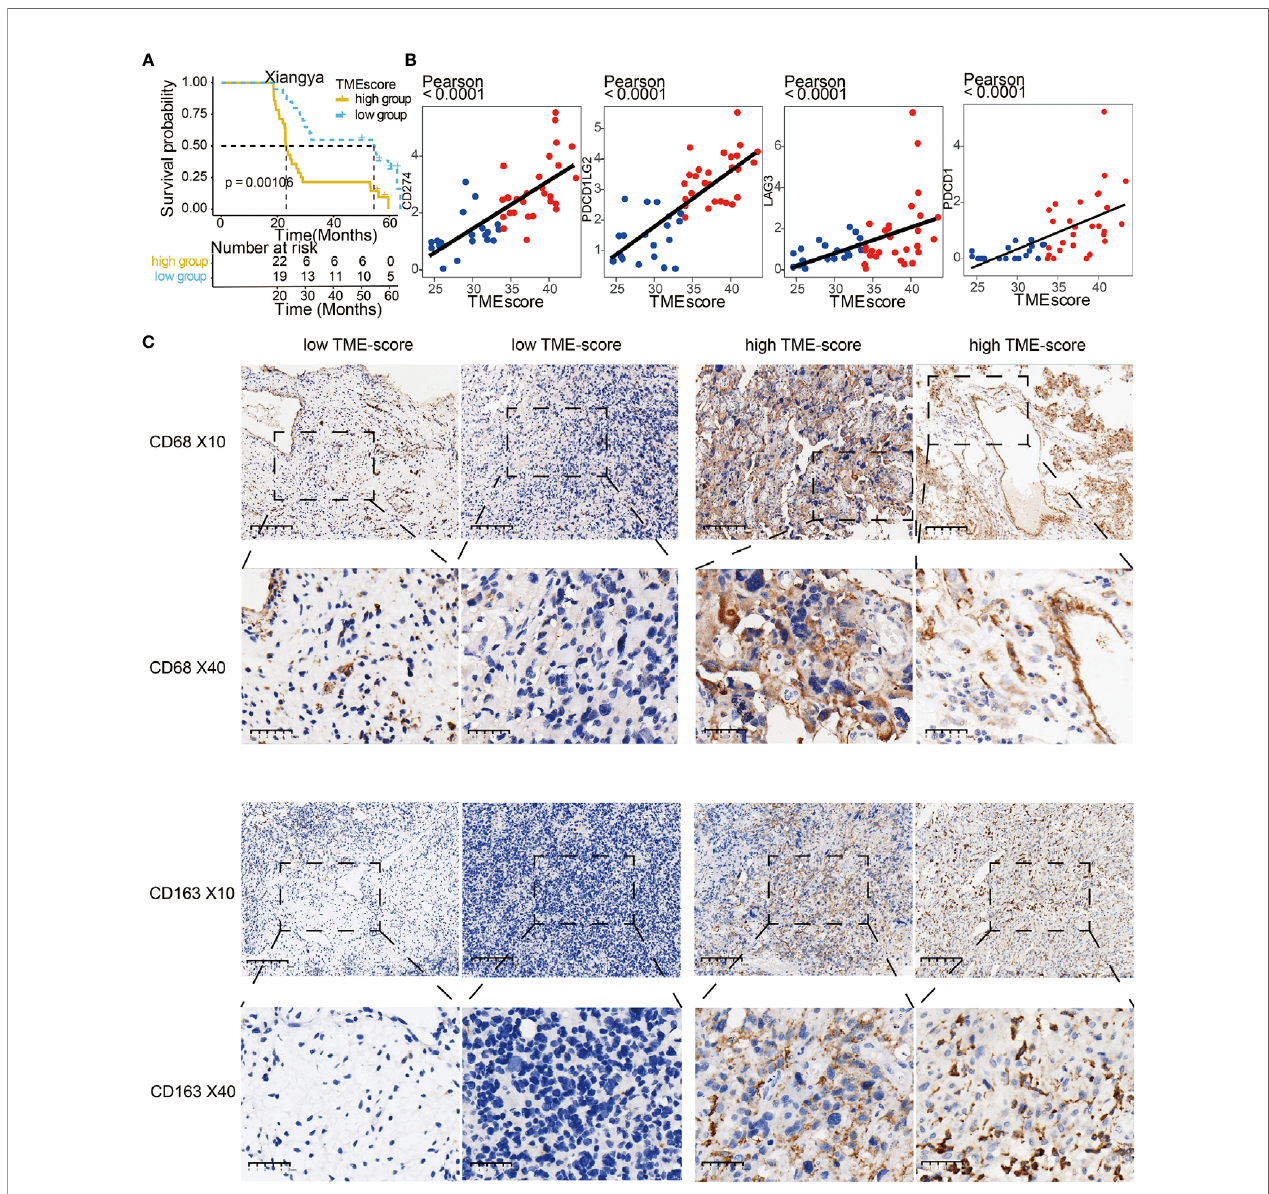
FIGURE 7 | Validation of TME-score in the XYNS cohort. (A) Kaplan – Meier curves for high and low TME-score patient groups in Xiangya samples. Log-rank test, P = 0.00106. (B) Scatter plots depicting a positive correlation between the TME-score and three classical immune checkpoints, CD274 , PDCD1LG2 , LAG3 , and PDCD1 . (C) Representative images of CD68 and CD163 IHC staining based on low and high TME-scores in Xiangya